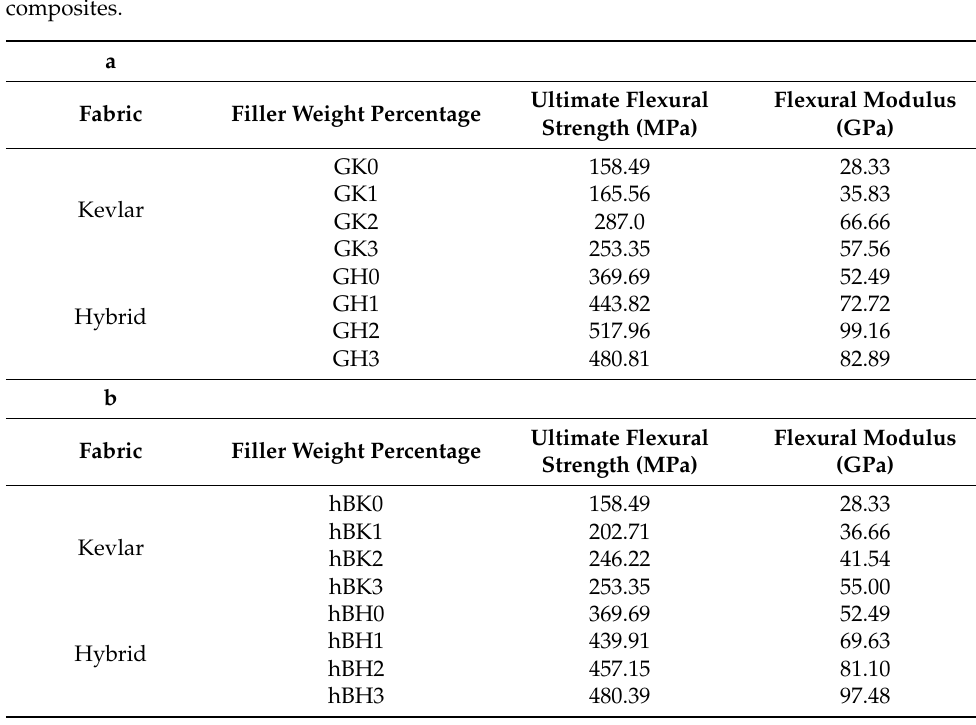
Figure 7. Flexure response of ( a ) graphene–Kevlar, ( b ) hBN–Kevlar; ultimate flexural strength of ( c ) graphene system, ( d ) hBN system; Flexure modulus of ( e ) graphene system, ( f ) hBN system. Table 6. ( a ). Flexural values of graphene-filled composites. ( b ) Flexural values of hBN-filled